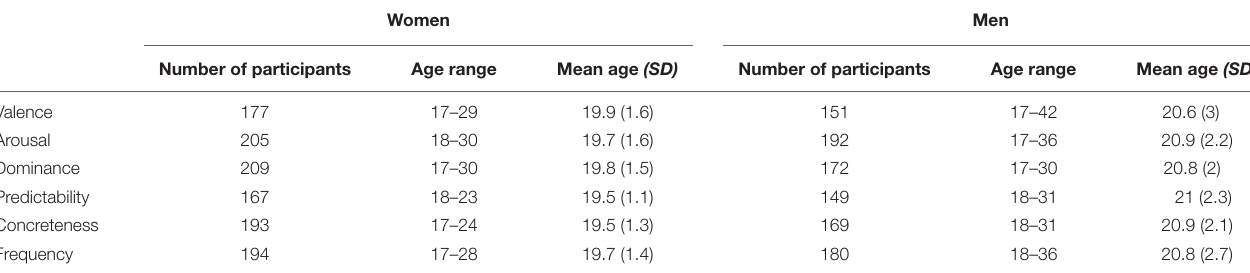
TABLE 1 | Summary of gender and age distributions in each